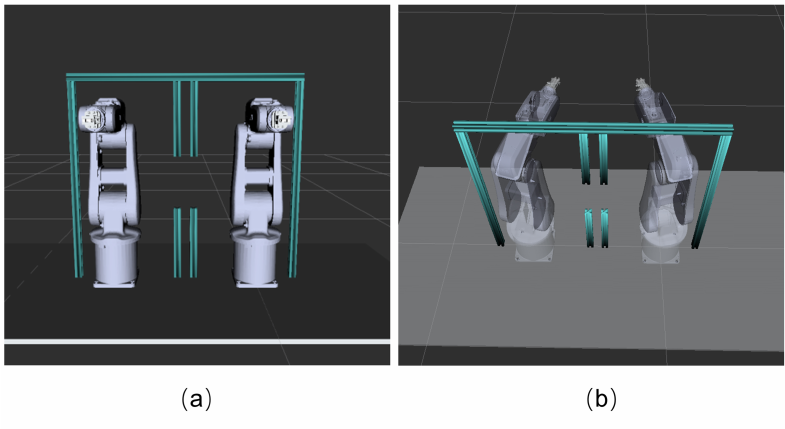
Figure 13. Experimental scenario 2. ( a ) Motion start state. ( b ) Motion end